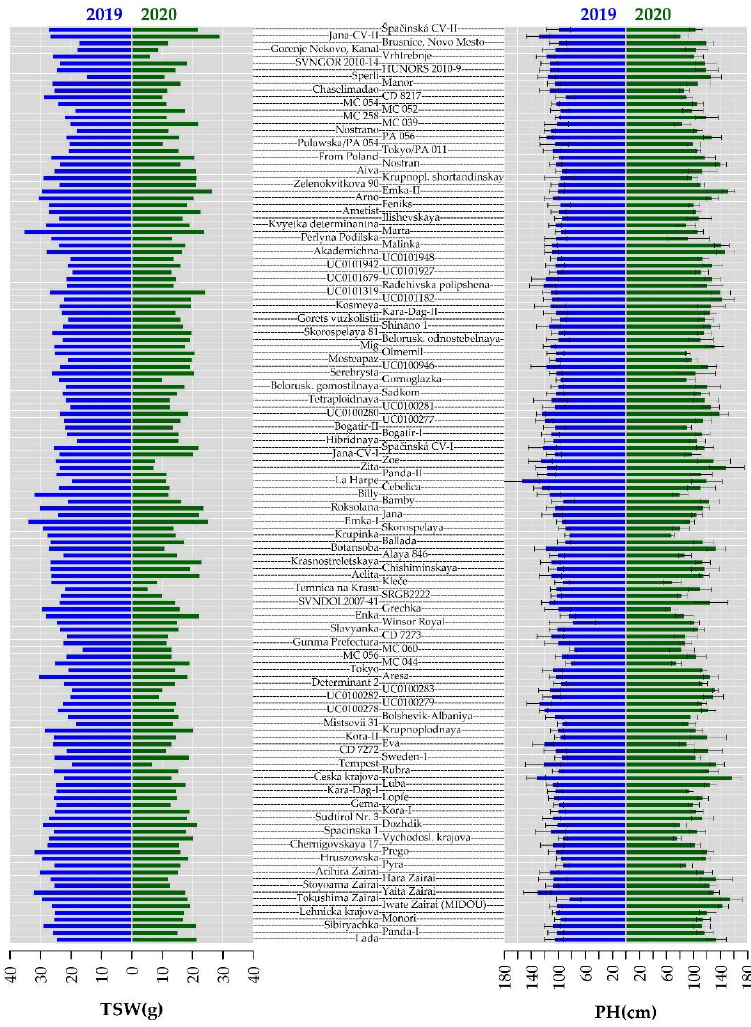
Figure 1. 1000-seed weight (TSW) and plant height (PH) observed for collection of 136 buckwheat genotypes. Blue and green bars represent data from 2019 and 2020, respectively. The values are depicted as mean value from respective year ± standard deviation.